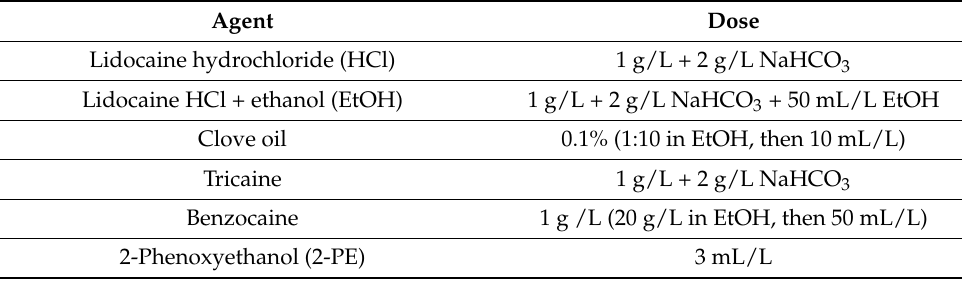
Table 3. Formulas for the anesthetic overdoses dissolved in the fish system